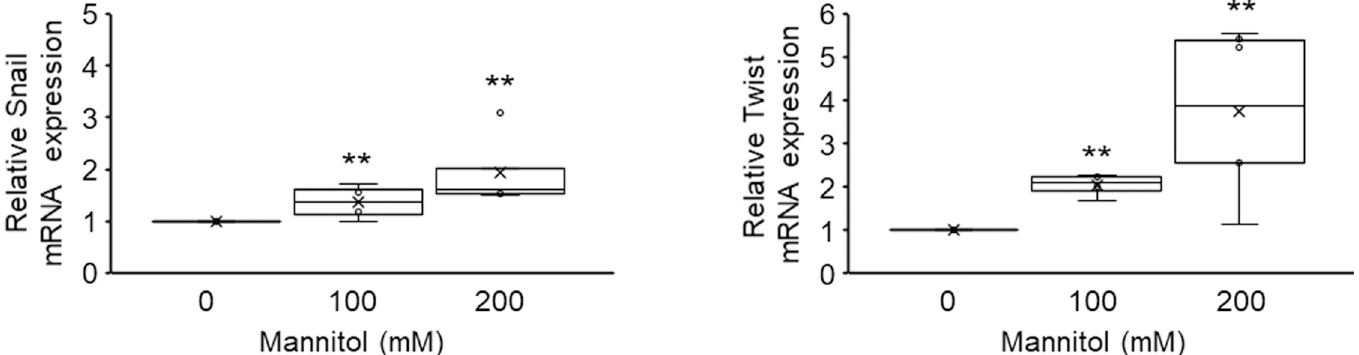
Fig 2. Effects of hyperosmotic mannitol stress on the expression of Snail and Twist. NRK-52E cells were treated with mannitol (0, 100, 200 mM) for 12 h, and mRNA expression was analyzed by real-time PCR. Quantitation of the changes in the mRNA expression of Snail (n = 6 from 0 mM, n = 4 from 100 mM, n = 5 from 200 mM) and Twist (n = 7 from 0 mM, n = 4 from 100 mM, n = 6 from 200 mM) by real-time PCR. Relative gene expression levels were calculated considering mannitol (0 mM) as 1 and plotted. Data are presented as box and whisker plots with average ( × ), median, IQR, and minimum and maximum values. The n indicates the number of independent experiments. �� P < 0.01 from the data of 0 mM (Steel test).